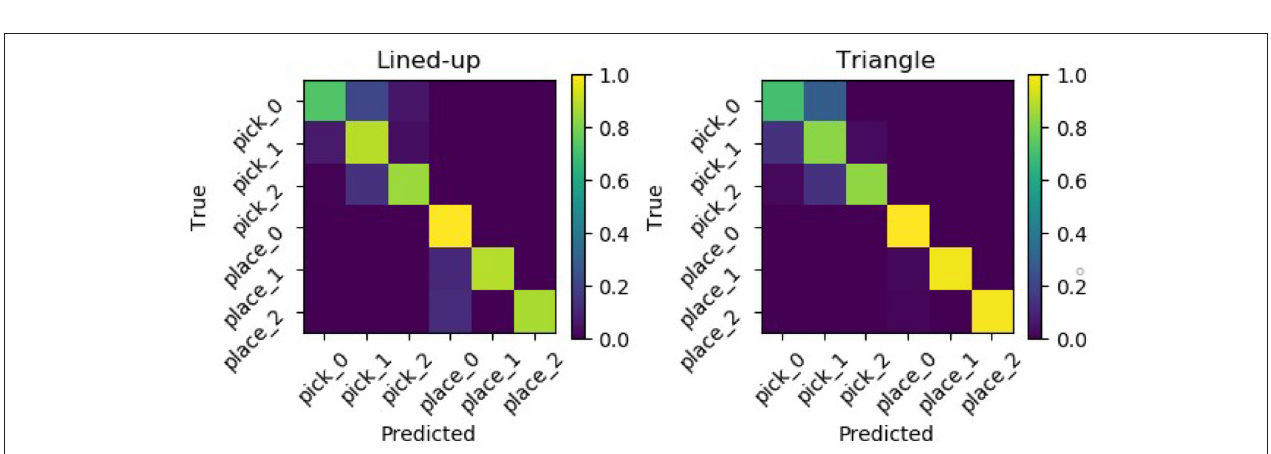
FIGURE 16 | Normalized confusion matrices from the semantic GHMM for the two used spatial